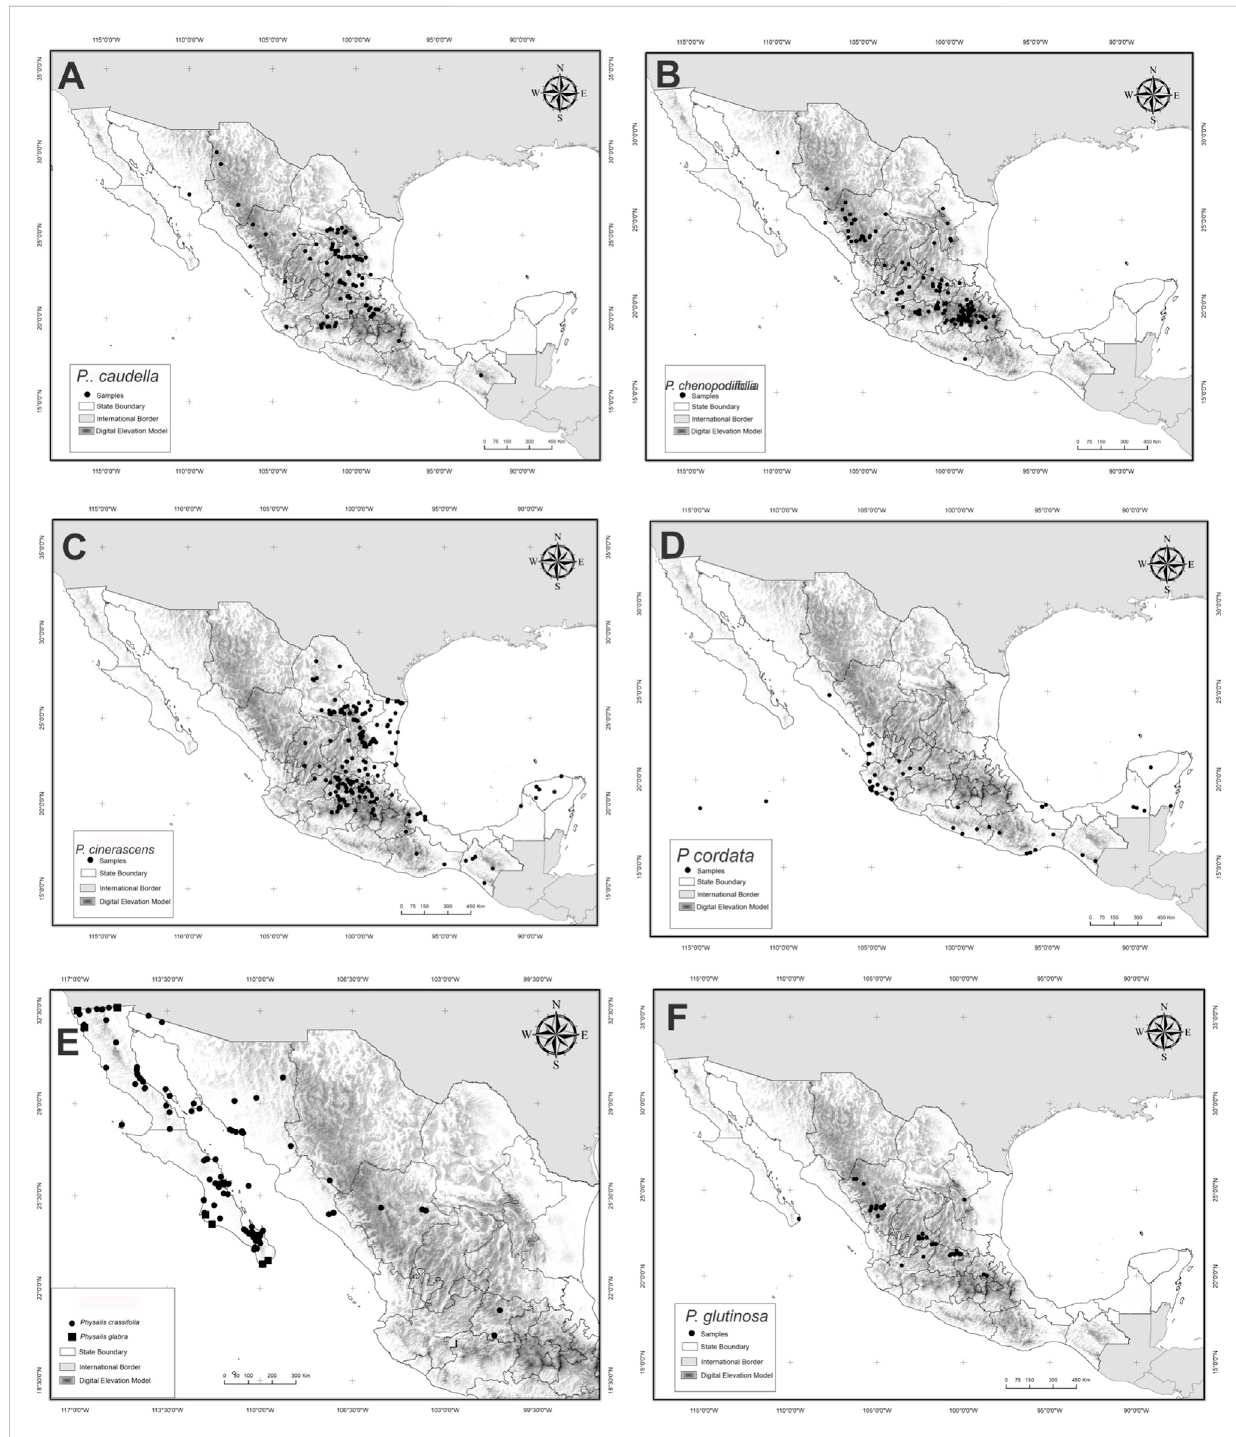
Distribution and habitat: A common plant of sandy soils near humid places, such as riparian or secondary and ruderal vegetation, associated with tropical deciduous or sub-deciduous forest; it develops from sea level to 1,300 m.